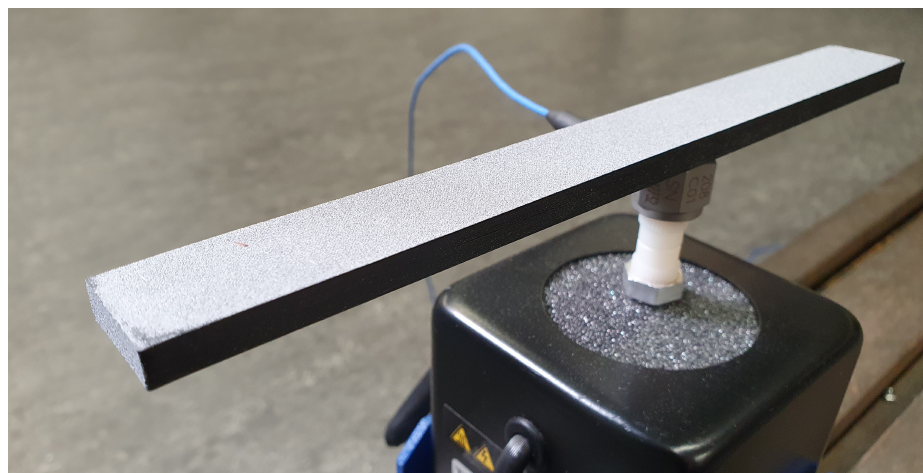
Figure 4. Experimental setup with 6mm beam mounted on electrodynamic shaker.